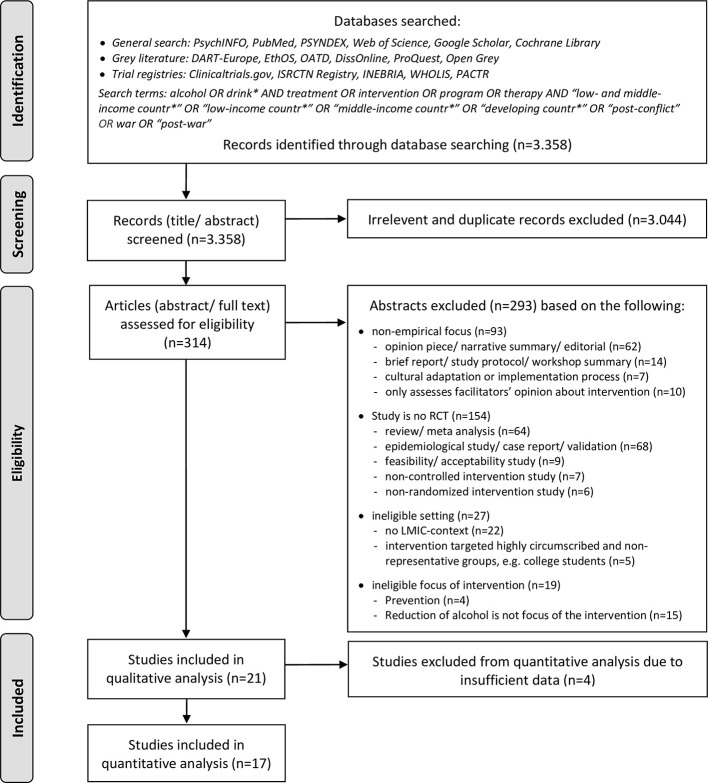
PRISMA flow diagram.